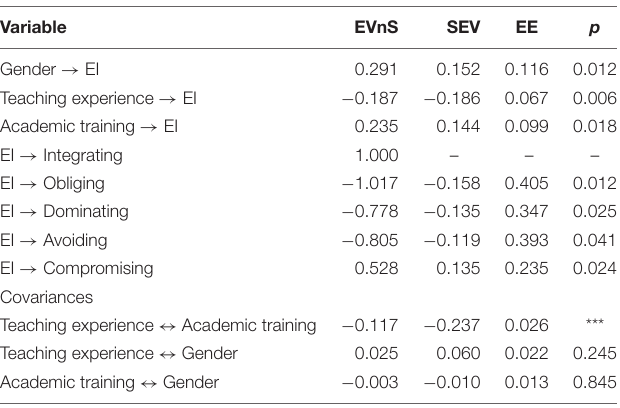
TABLE 1 | Descriptive data for the variables included in the model.